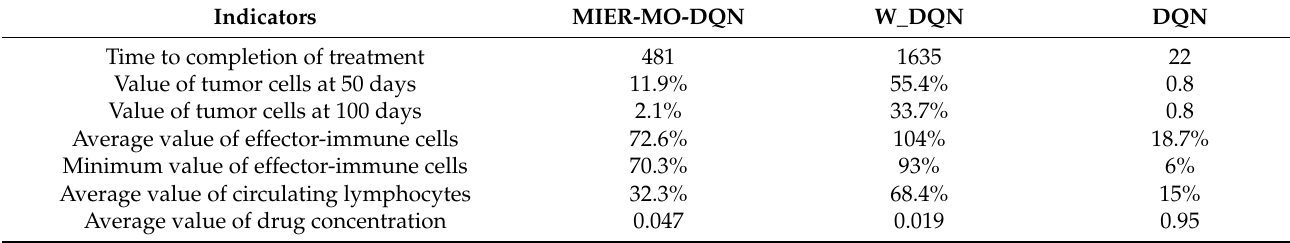
Table 5. Comparison of experimental indicators in different methods.